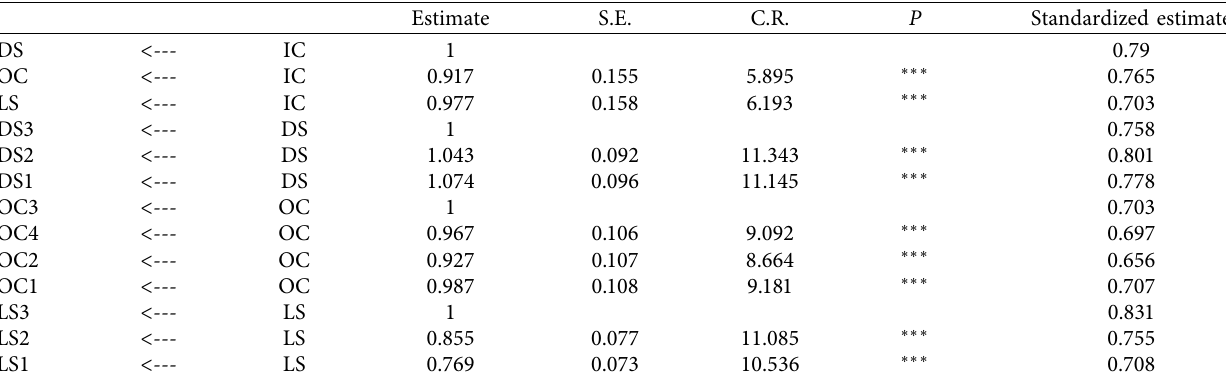
Table 7: Second-order factor convergence validity coefficient of internal